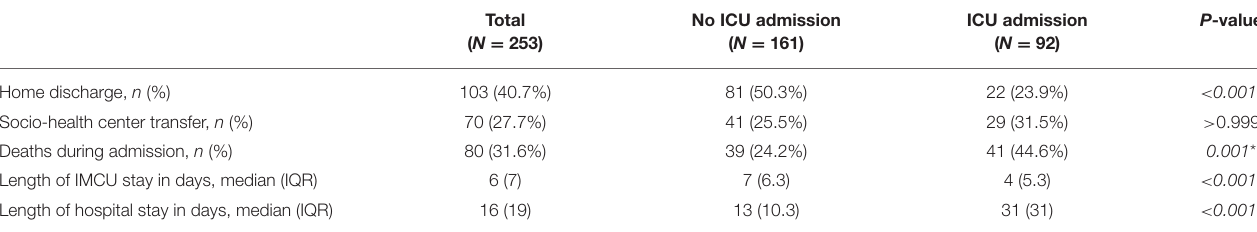
TABLE 2 | Clinical outcomes of all patients admitted to the respiratory intermediate care unit, and according to requirement of transfer to the ICU.